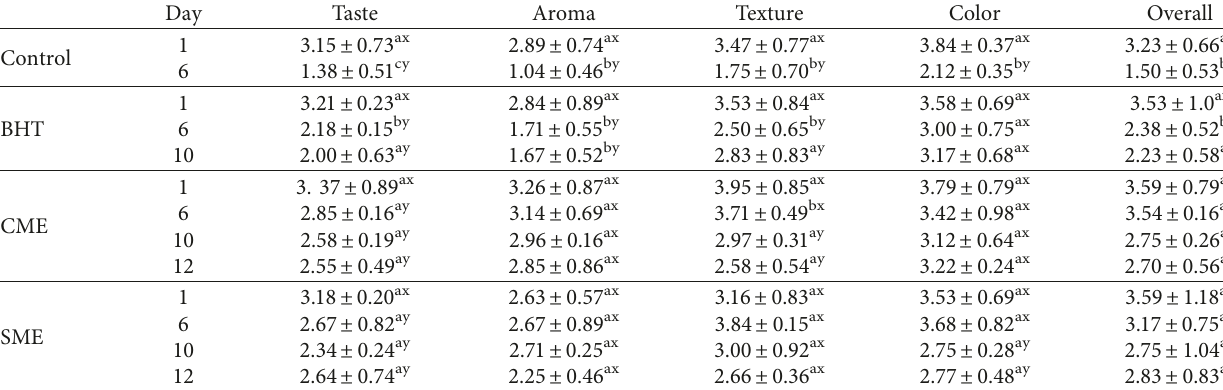
Table 4: The sensory opinions of the panelists on control and antioxidant-added baked